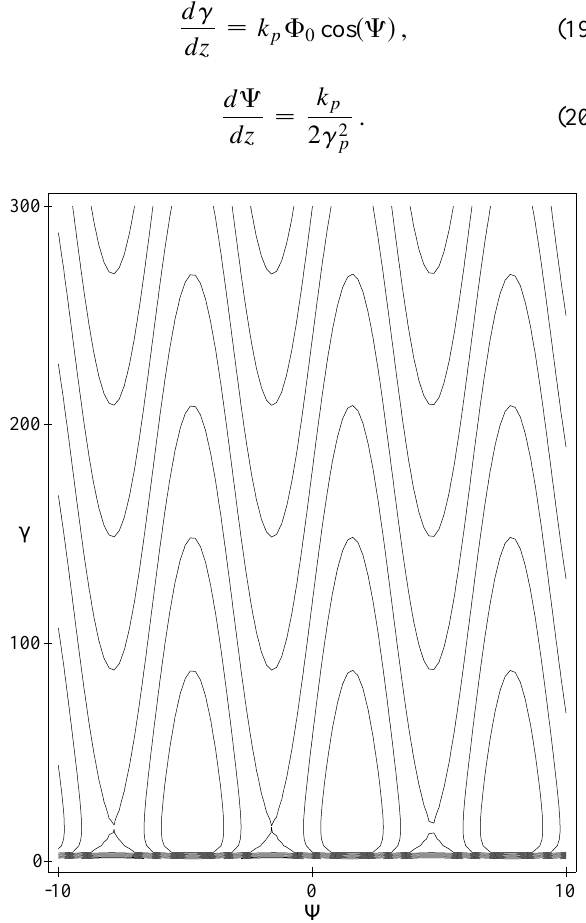
FIG. 1. The longitudinal phase space: electron Lorenz factor g vs its phase with respect to the wakefield C . The parameters used were g p (cid:1) 15 , F 0 (cid:1) 0.2